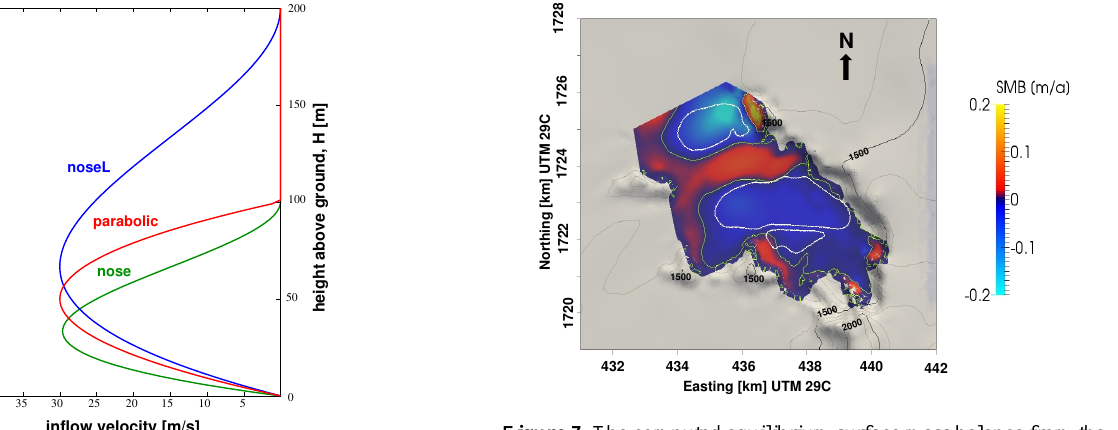
Figure 7. The computed equilibrium surface mass balance from the ice flow simulation by Zwinger et al. (2014). The colours – con- fined to the glaciated area inside the valley – show the equilibrium surface mass balance (Eq. 10) in ma − 1 ice equivalent (density of ice, ρ i = 910kgm − 3 ). The yellow line confines the ablation zones and the white lines depict the outline of the BIAs (see Fig. 2). The grey contour lines show the elevation of the wider terrain in steps of 100m, the black in steps of 500m (annotated by their